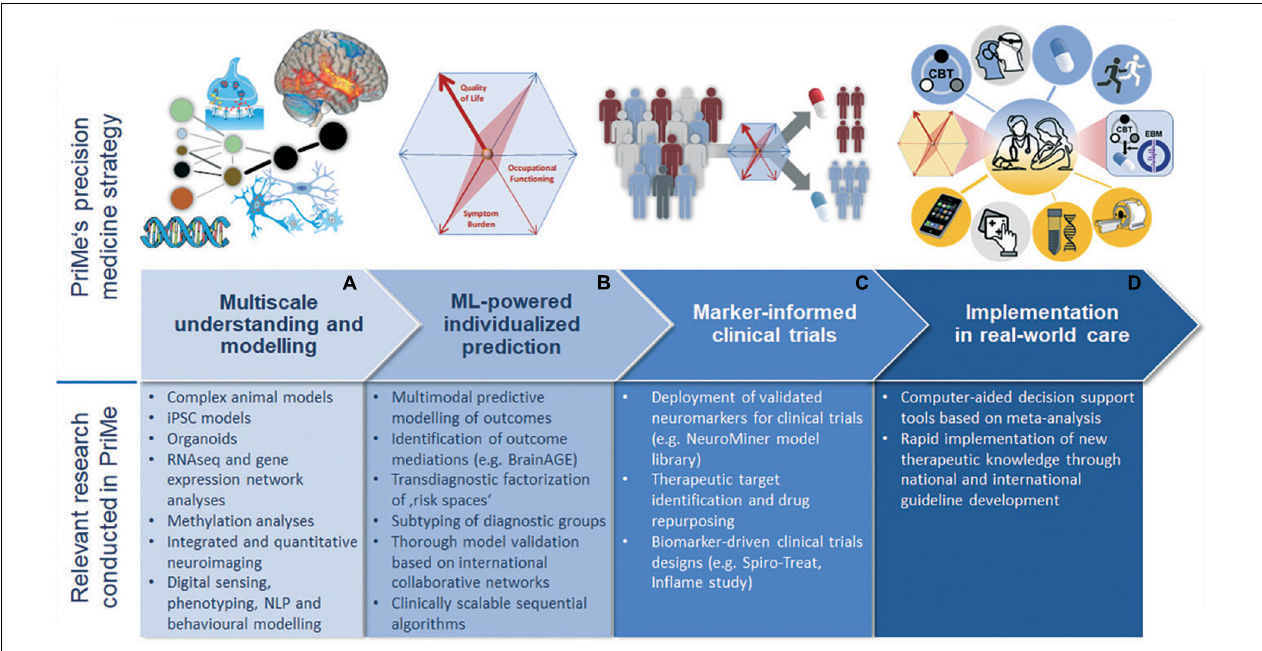
FIGURE 3 | Concept figure representing the translational chain from understanding over development of predictive tools to their translation into clinical practice through stratified clinical trials (A–D) . The upper part depicts the envisaged bench-to-bedside sequence, while the lower part lists relevant research activities at each translational step that are being pursued by PriMe. iPSC, induced pluripotent stem cells; ML, machine learning; MRI, magnetic resonance imaging; NLP, neurolinguistic programming; NTBS, non-invasive transcranial brain stimulation; and PriMe, Precision in Mental